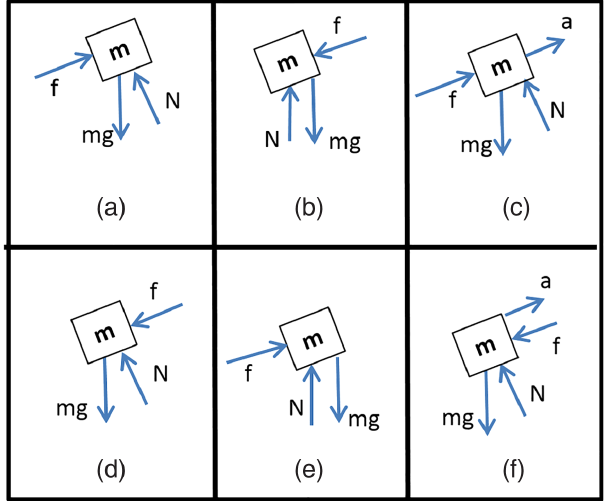
FIG. 11. Answer choices given for question 1 on version B of week 7, level 1 problems.